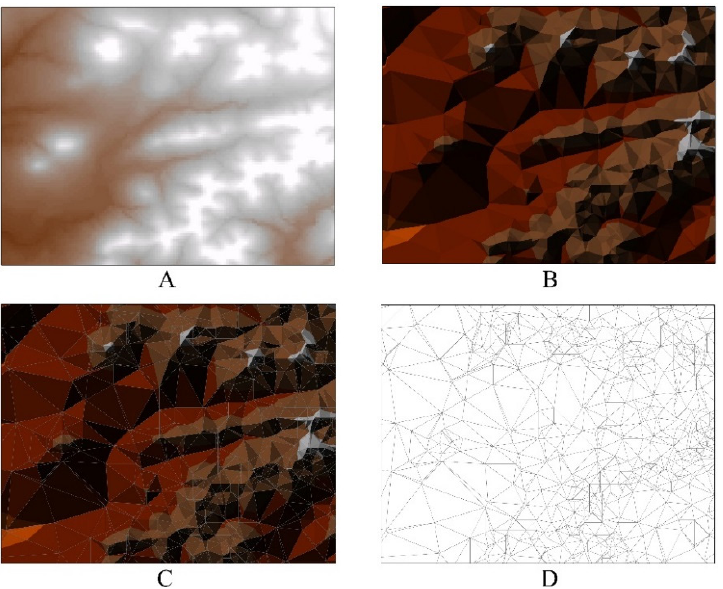
Figure 5. DEM ( A ) converts to TIN ( B ), TIN with edges ( C ), and to triangle features ( D ).